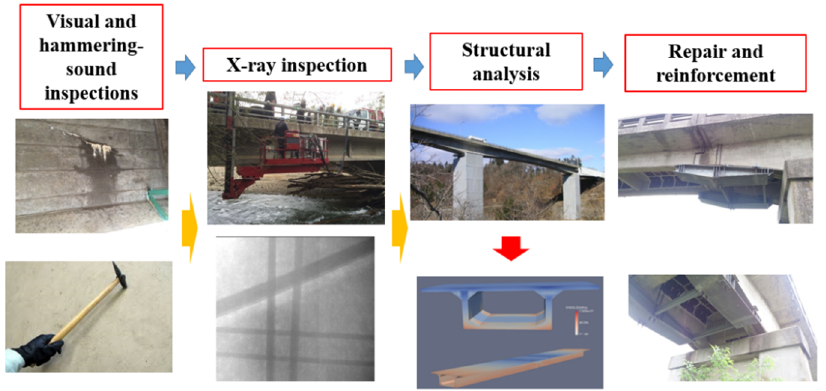
Figure 37. Proposed guideline for X-ray inspection using 950 keV/3.95 MeV X-ray sources accompanied with visual and hammering-sound screenings, structural analysis, final repair, and/or reinforcement.